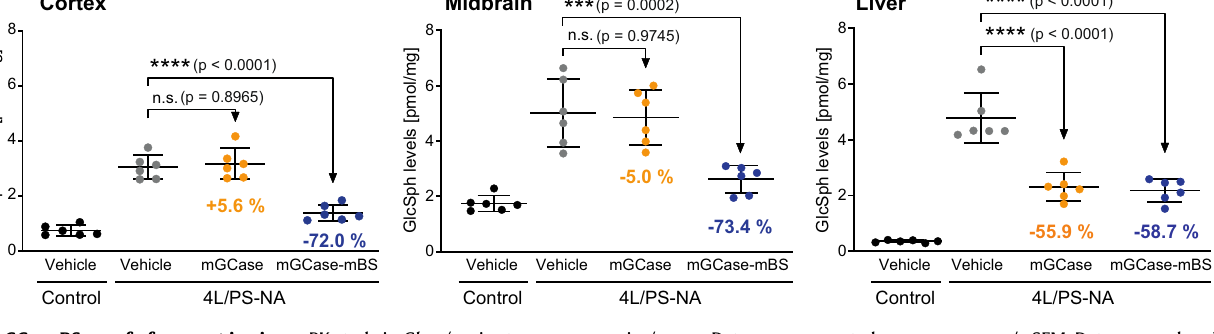
Fig. 6 | GCase-BS proof of concept in vivo. a PK study in Gba + /+ mice to assess systemicexposureof mGCase-mBSin plasma and brain. n =3 mice/group. b Multi- dose PD study in 4L/PS-NA mice to compare equimolar doses of mGCase vs. mGCase-mBS. GlcSph levels were measured in cortex, midbrain and liver. n =6